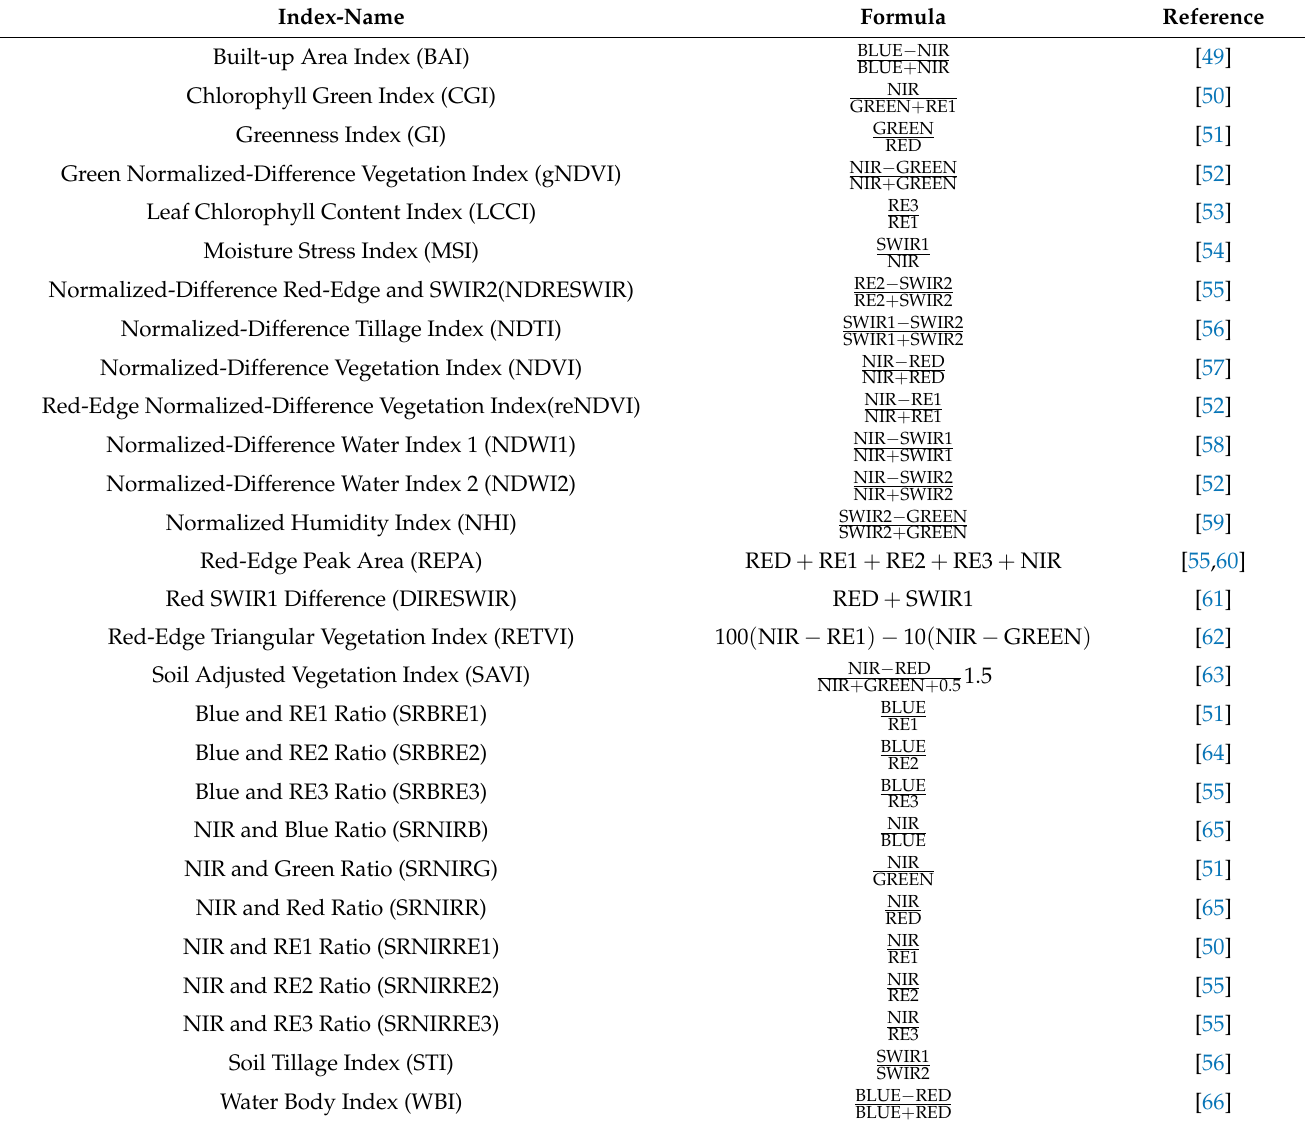
Table A1. Summary of the additional vegetation indices used for the classification, together with the corresponding formula and references (band 8 was used for the NIR = Near-Infrared; RE =